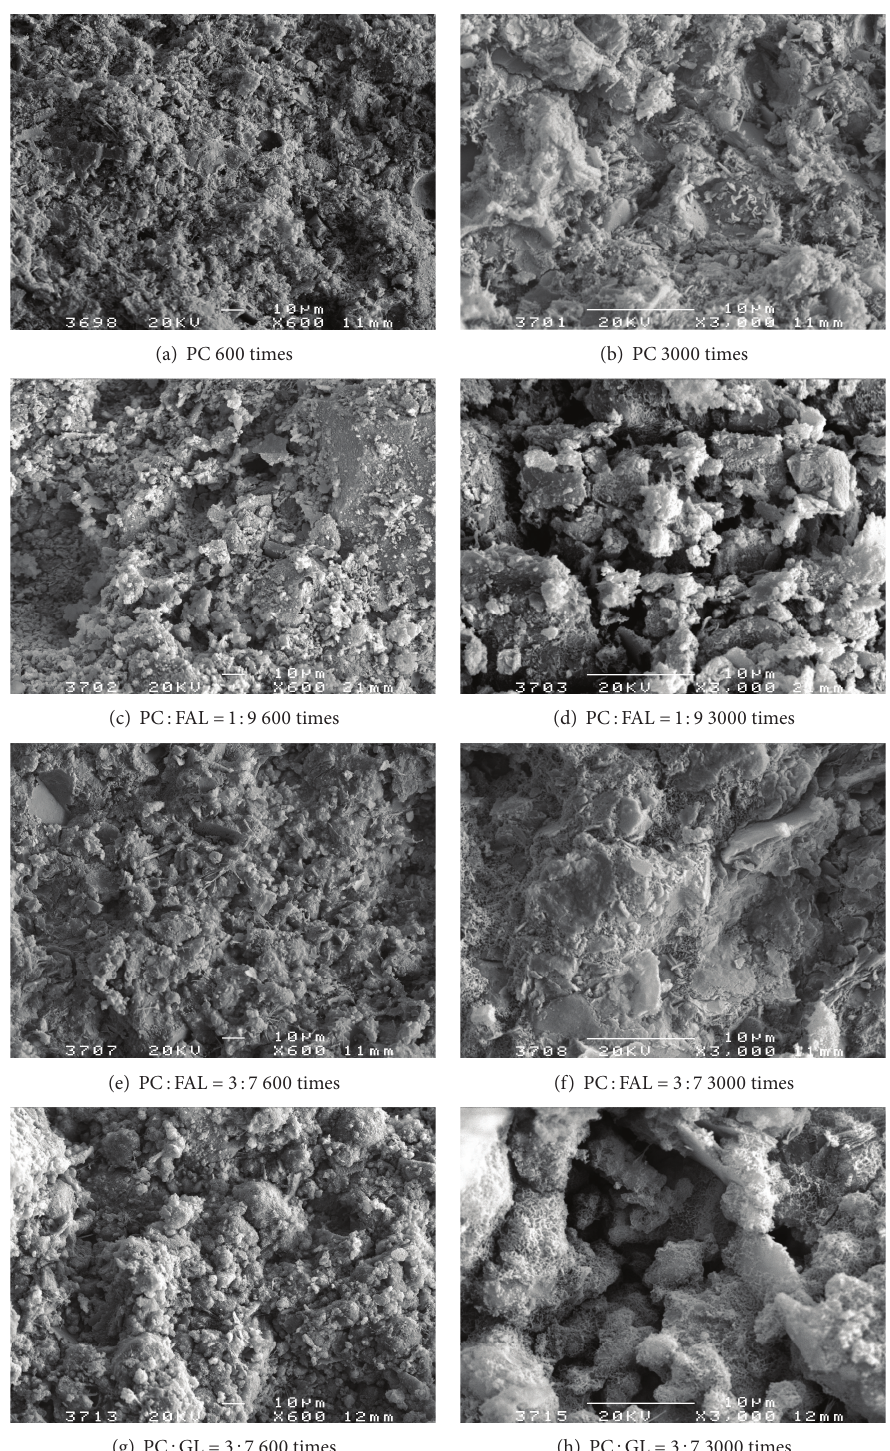
Figure 8: Scanning electron micrograph of 25% binder stabilized clay at 28